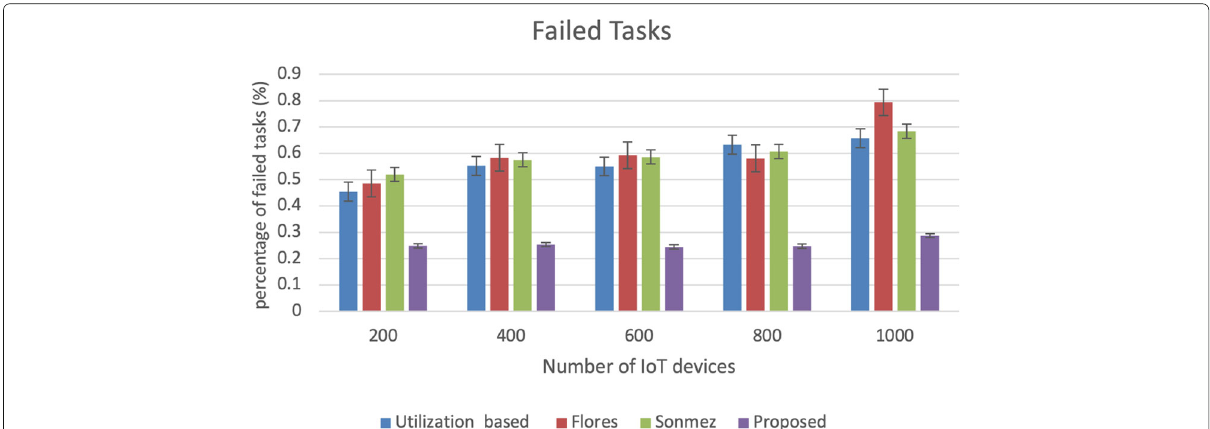
Fig. 11 Percentage of failed tasks of the proposed approach with other related approaches part